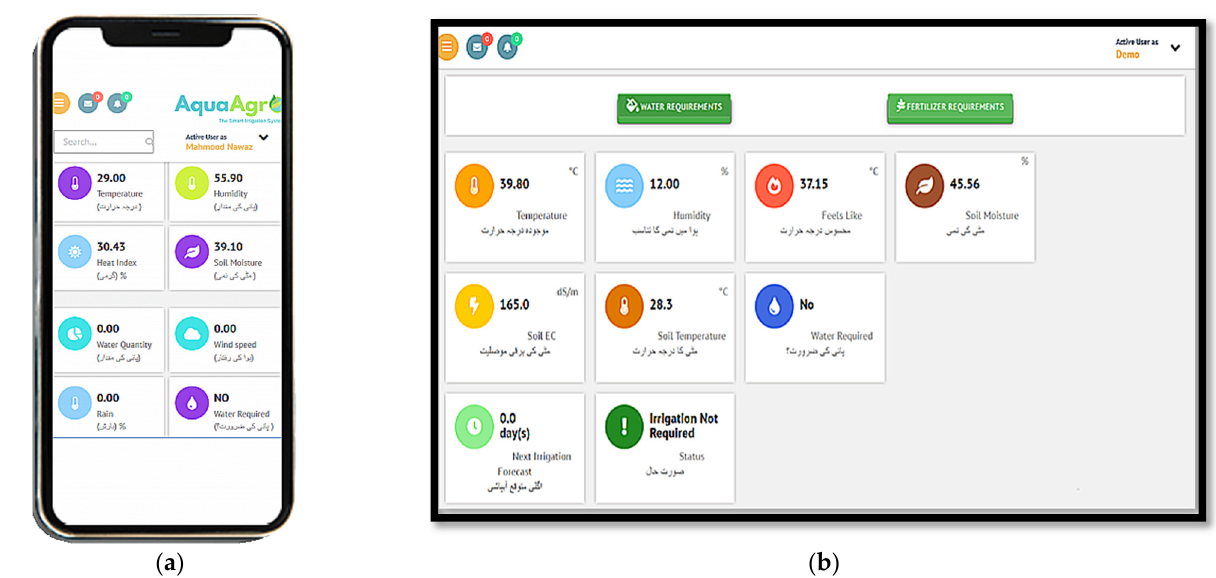
Figure 7. ( a ) Android application and ( b ) web portal for information visualization for the farmer.